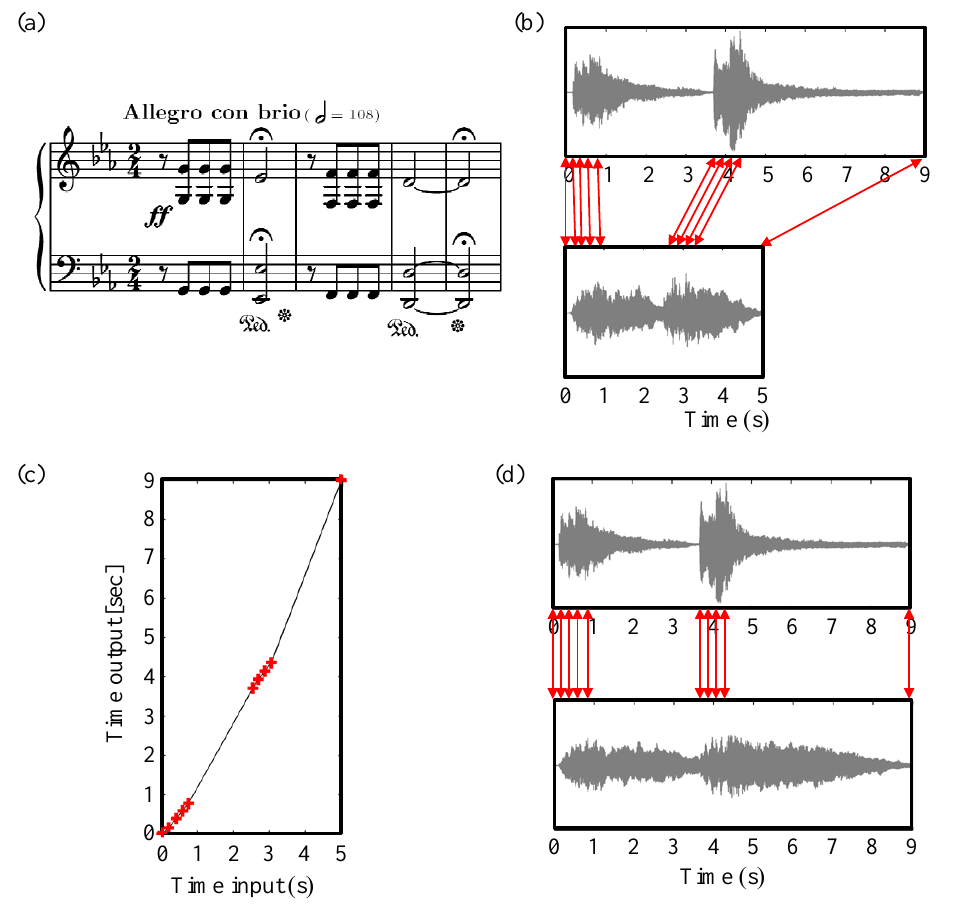
Figure 15. ( a ) Score of the first five measures of Beethoven’s Symphony No. 5; ( b ) Waveforms of two performances. Corresponding onset positions are indicated by red arrows; ( c ) Set of anchor points (indicated in red) and inferred time-stretch function τ ; ( d ) Onset-synchronized waveforms of the two